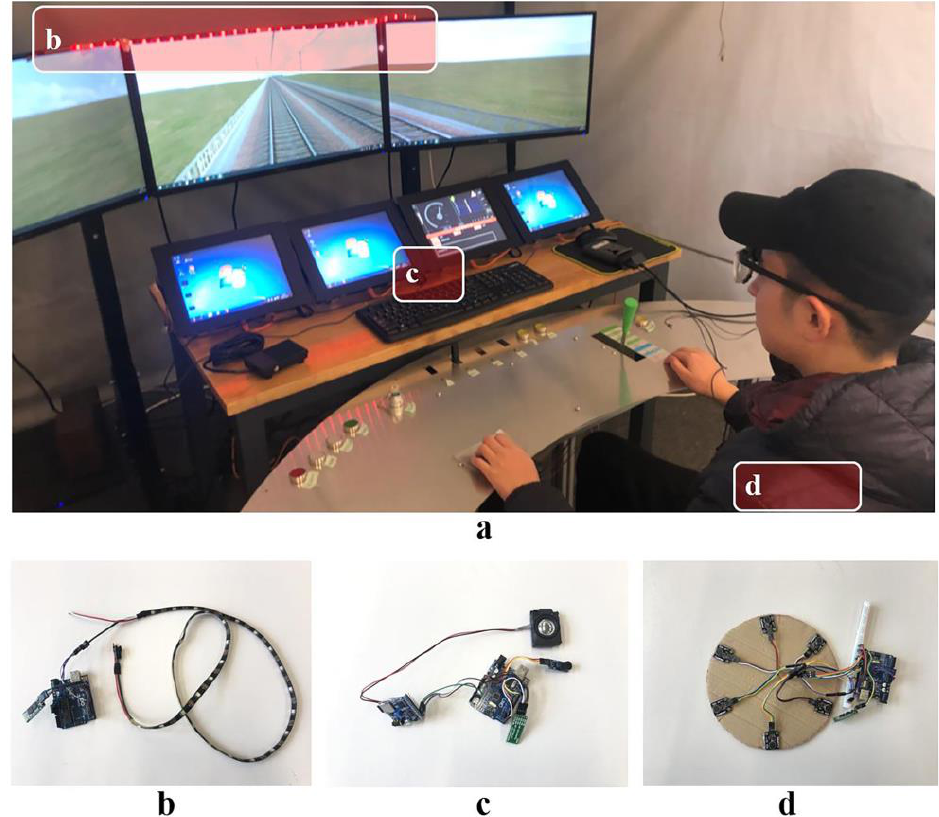
Figure 2. High-speed train simulation driving platform and multi-modal warning interface prototype (( a ) high-speed train simulation driving platform; ( b ) visual interface prototype and action location; ( c ) visual interface prototype and action location; ( d ) tactile interface prototype and auction location).